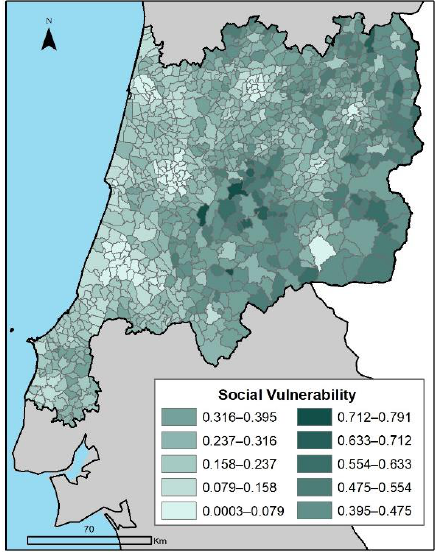
Figure 8. Social vulnerability. Values were classified in equal intervals.